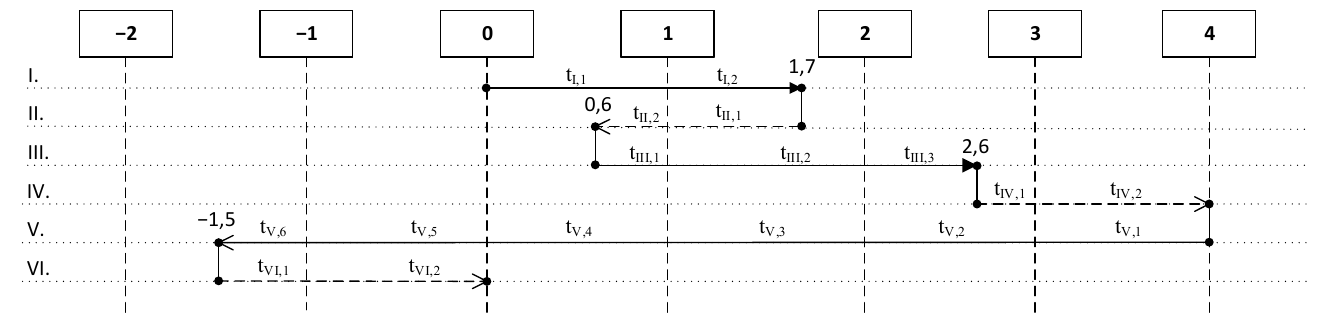
Figure 3. Diagram of the life cycle of object in the first scenario. Source: developed by the authors.